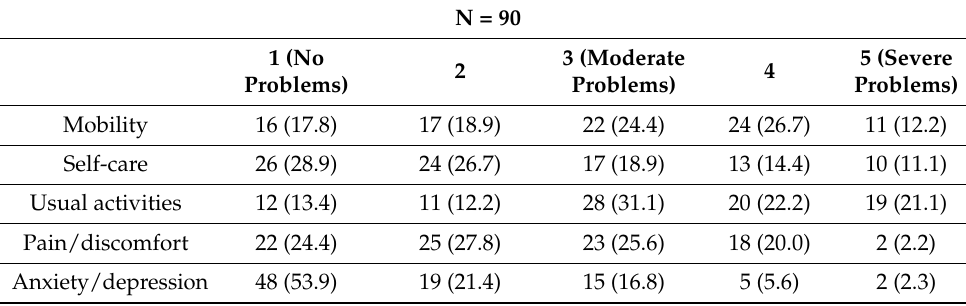
Table 4. EQ-5D subscale